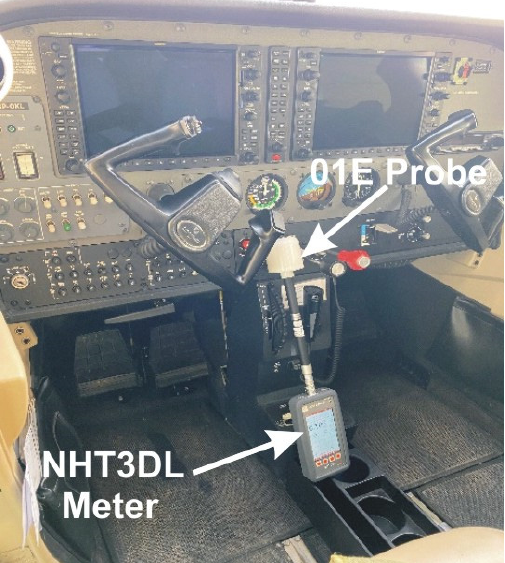
Figure 2. The Microrad NHT3DL electric field meter with 01E measuring probe, installed in the Cessna C172 aircraft.